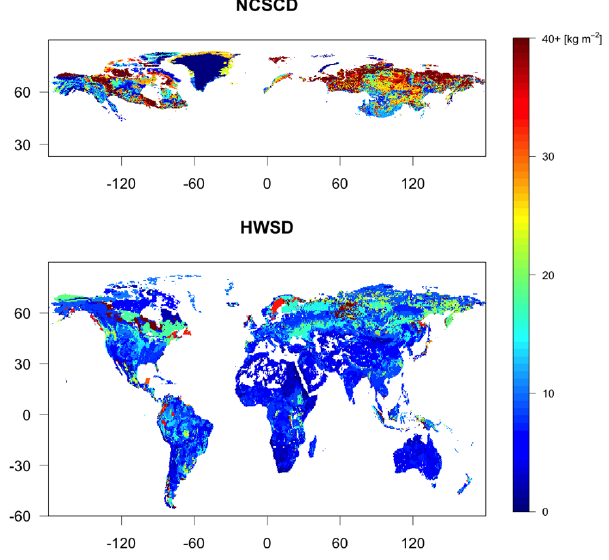
Fig. 1. Carbon density [kgm − 2 ] in the top 1m of soil from the Northern Circumpolar Soil Carbon Database (NCSCD) (Tarnocai et al., 2009) and Harmonized World Soil Database (HWSD) (FAO/IIASA/ISRIC/ISSCAS/JRC,